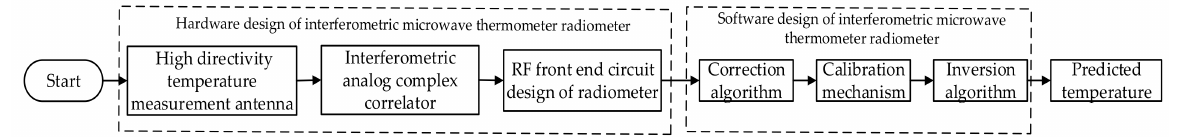
Figure 2. The design flow chart of the novel interferometric microwave thermometer